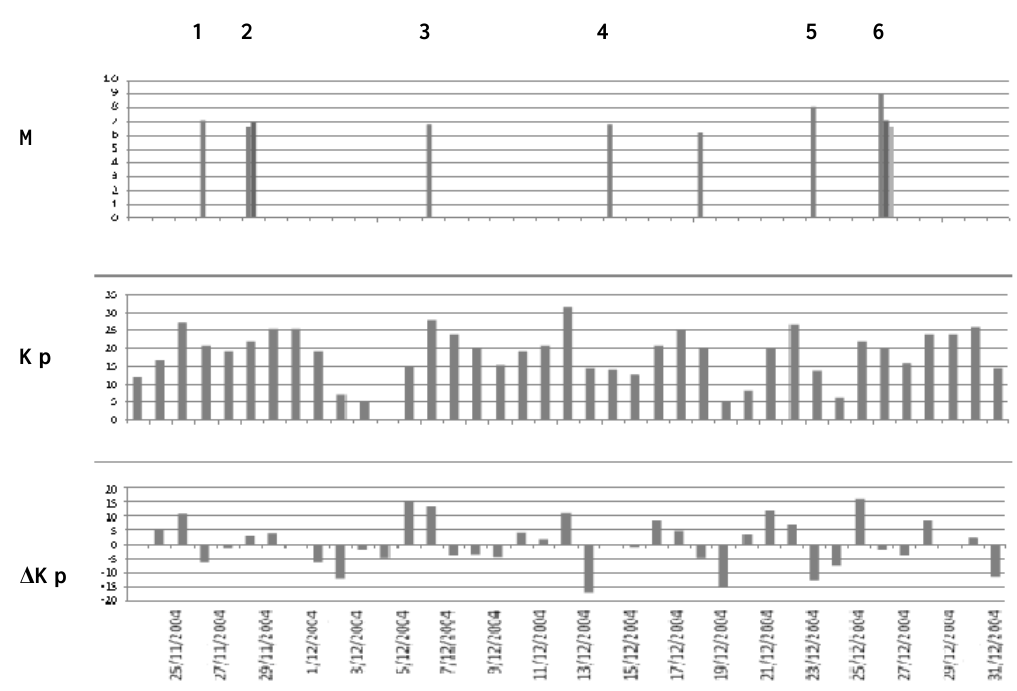
Fig. 2. The figure displays the magnitude of the six earthquakes (the top panel) along with the daily numbers of the geomagnetic activity index K p (middle panel) and the daily variation the same index 1K p (bottom panel); the six significant ( > 6.8) earthquakes shown in Table 1 are numbered as #1–6 above the